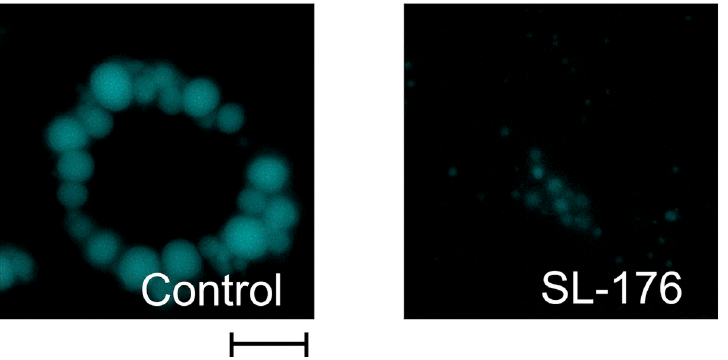
Fig 3. SL-176 significantly reduced the size of lipid droplets in 3T3-L1 cells. After treatment of SL-176 during adipocyte differentiation (from Day0 to Day8), lipid droplets in differentiated 3T3-L1 cells on Day 8 were stained by Monodansylpentane. Scale bar = 10 μ